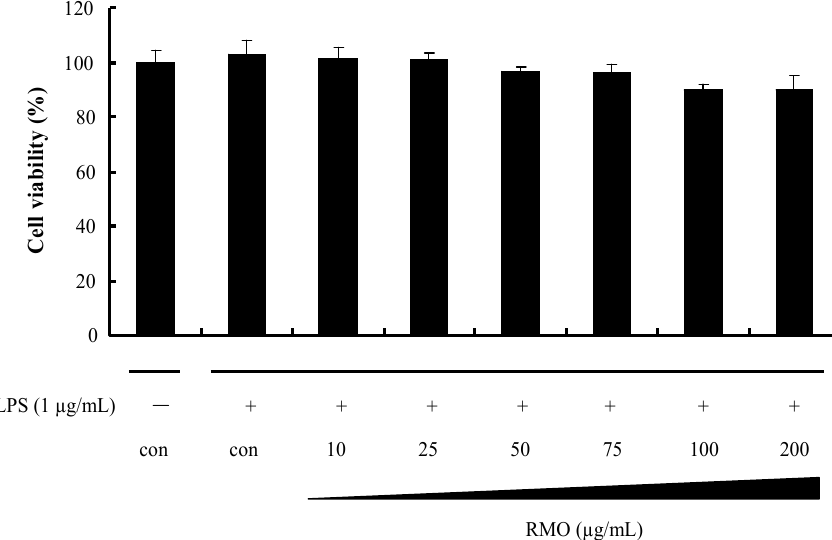
Figure 1. Effects of RMO on LPS-induced RAW264.7 cell viability. Cells were treated with different concentrations of RMO for 48 h, and cell viabilities were determined by MTT